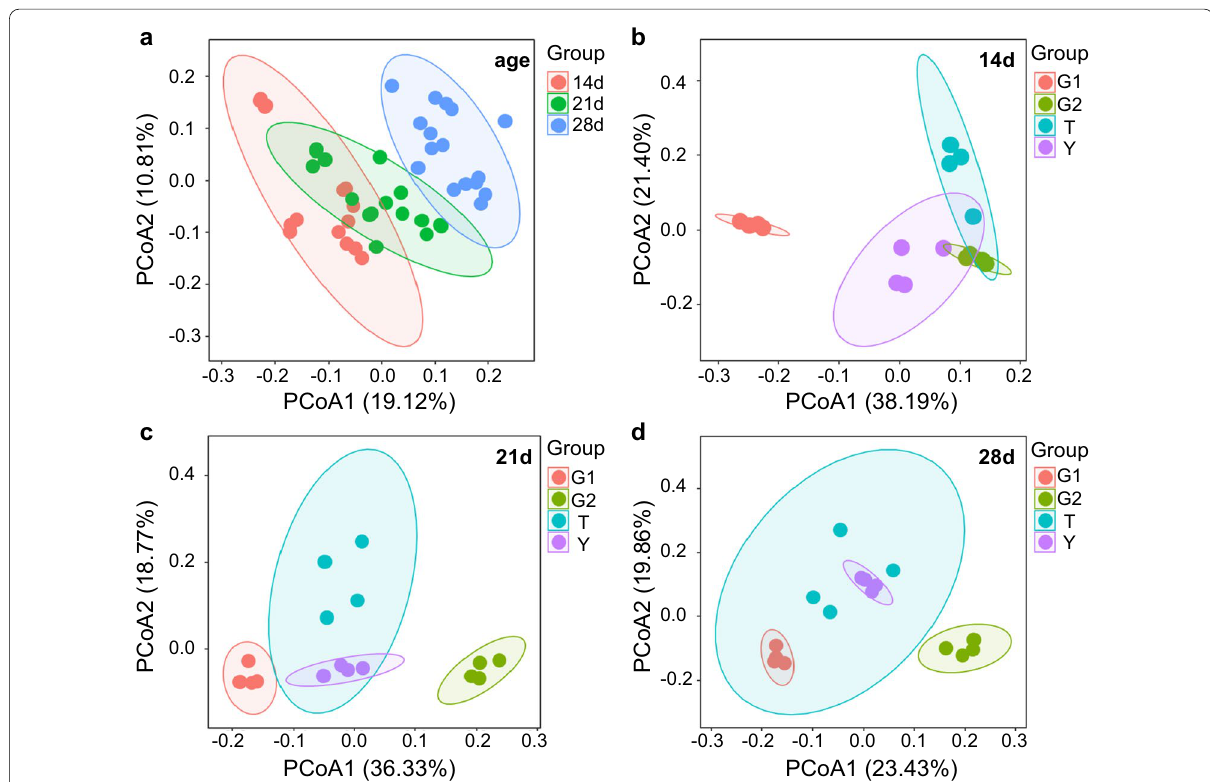
Fig. 5 PCoA of the broilers gut microbial community composition of different age a , and the Y (control group), T (antibiotic group), G1 (0.1% β-1,3/1,6-glucan), and G2 (0.2% β-1,3/1,6-glucan) group of broilers aged 14 days b , 21 days c and 28 days d based on the Bray–Curtis distances showed distinct clusters. The cecum microbial community structure between the 14, 21, and 28 days of age were differentiated by colors (red, green, blue, respectively). The cecum microbial community structure between the Y, T, G1, and G2 groups were differentiated by colors (purple, blue, green, red,